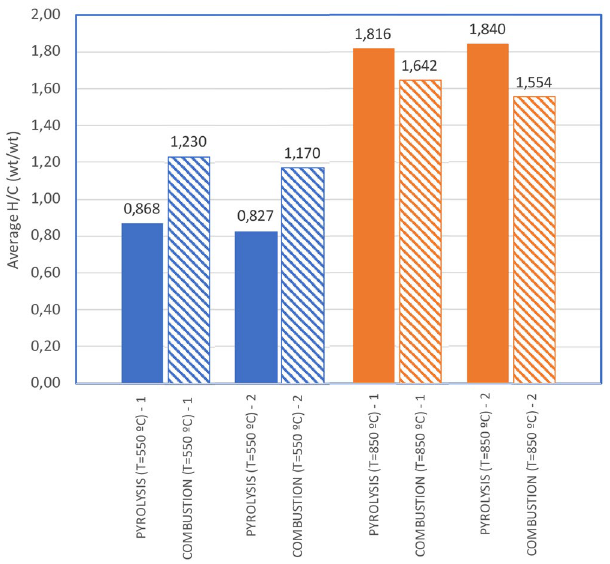
Figure 4. Average H/C ratio during the pyrolysis ( λ C = 0,11) and combustion ( λ C = 0,84) of flexible polyurethane foams (FPUF) at two different temperatures (550 °C and 850 °C). Duplicated